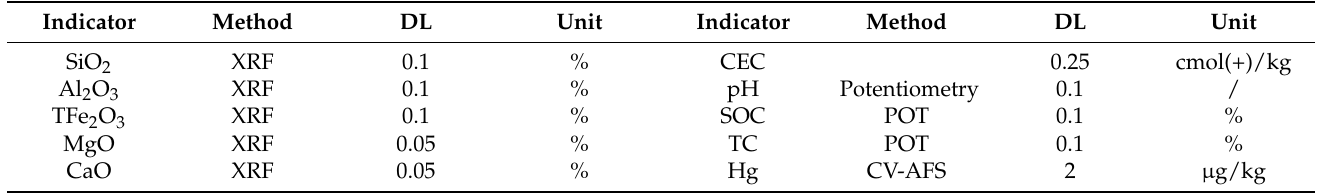
Table 2. The methods and detection limit of soil samples